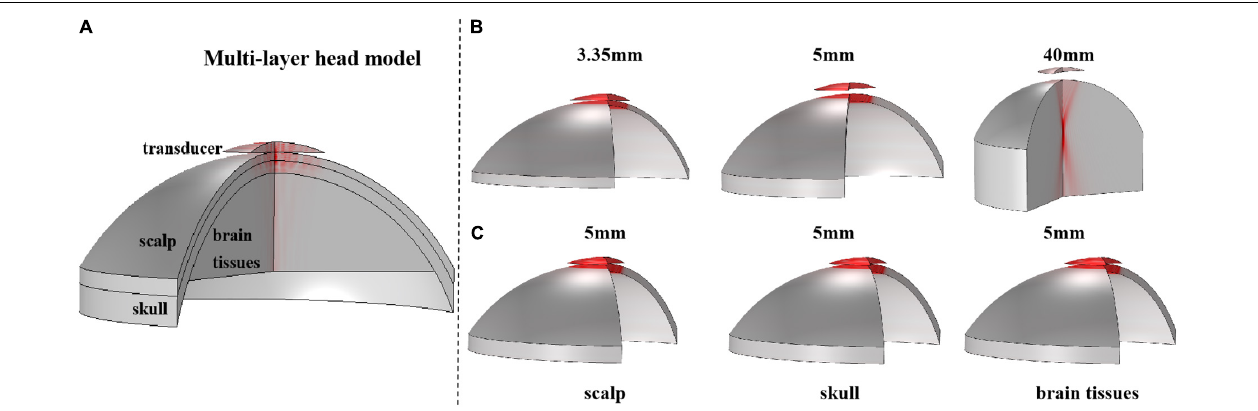
FIGURE 2 | The 3-D structure of the multilayer head model and single-layer head tissue model. (A) Multilayer head model, including scalp, skull, and brain tissue, and the thickness is 3.35 and 5 mm and 4 cm, respectively. The top is a bowl-shaped ultrasound transducer. (B) 3-D structure of single-layer head tissue model with different thicknesses. The thickness of scalp, skull, and brain tissue is 3.35 and 5 mm and 4 cm, respectively. (C) 3-D structure of single-layer head tissue model with the same thickness. The thickness of scalp, skull, and brain tissue is unified to 5 mm.